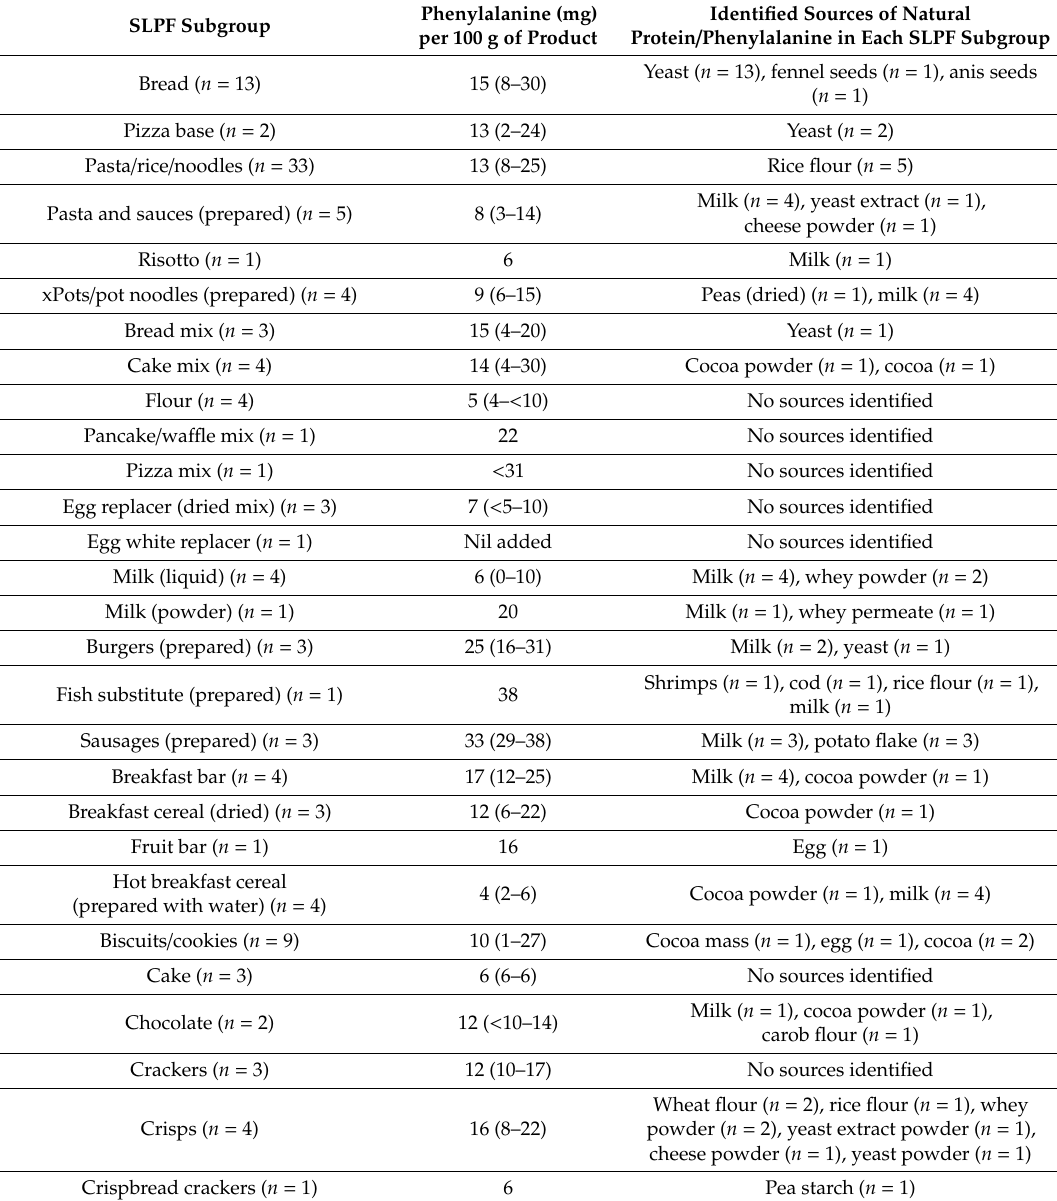
Table 1. Phenylalanine content and identified sources of natural protein for all special low protein food (SLPF) subgroups. Values displayed as mean